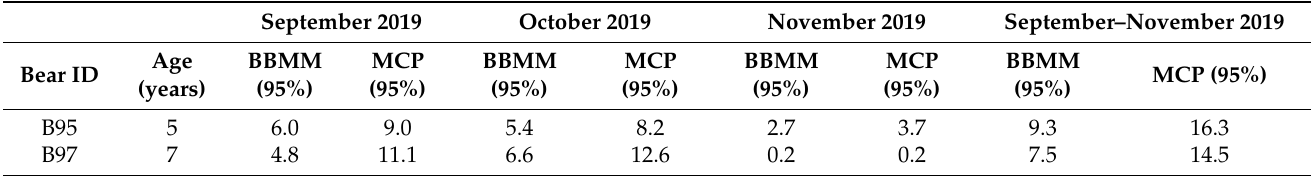
Table 1. Brownian Bridge Movement Model (BBMM) in km 2 of bear B95 and B97 from September until November 2019 as 95% of their seasonal home range as well as minimum convex polygon (MCP) as 95% in km 2 . In November, bear B95 was active for 14 days and bear B97 for only four